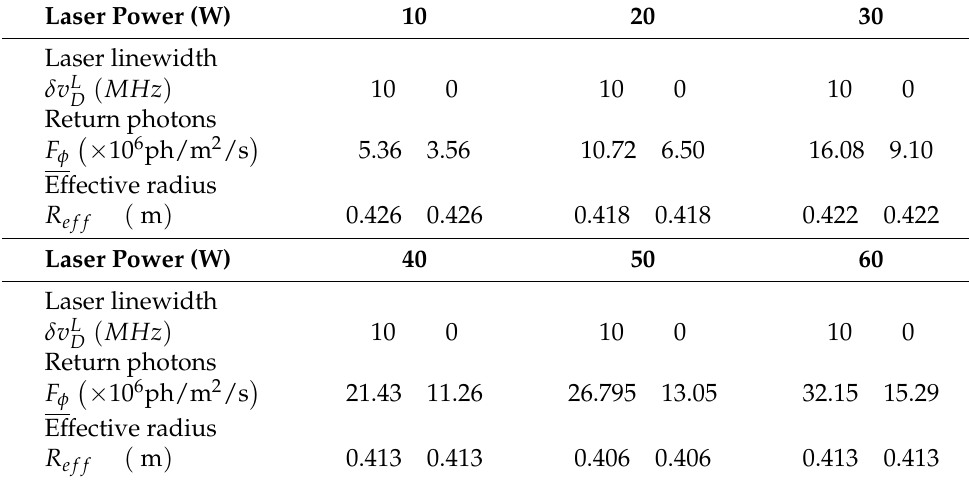
Table 2. Return photons and effective radii of spot